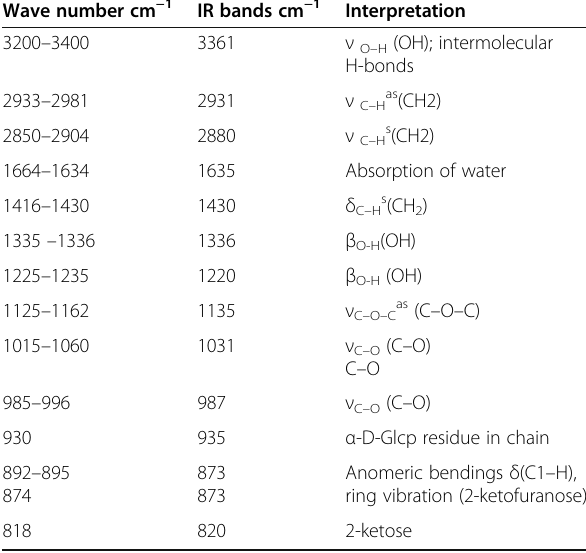
Table 4 Interpretation of FT- IR spectra of isolated